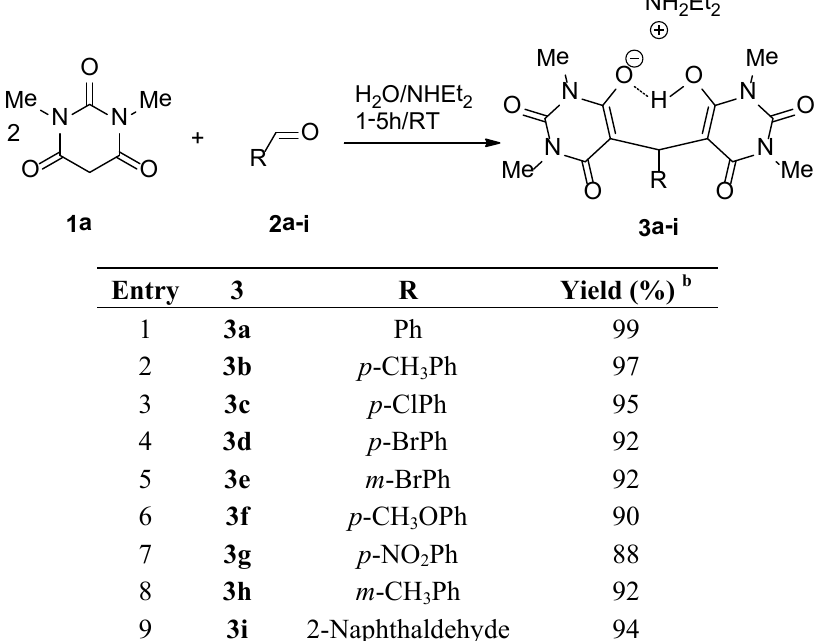
Table 2. Tandem Aldol-Michael reactions of 1,3-dimethylbarbituric acid 1a with aldehydes in aqueous diethylamine medium a .